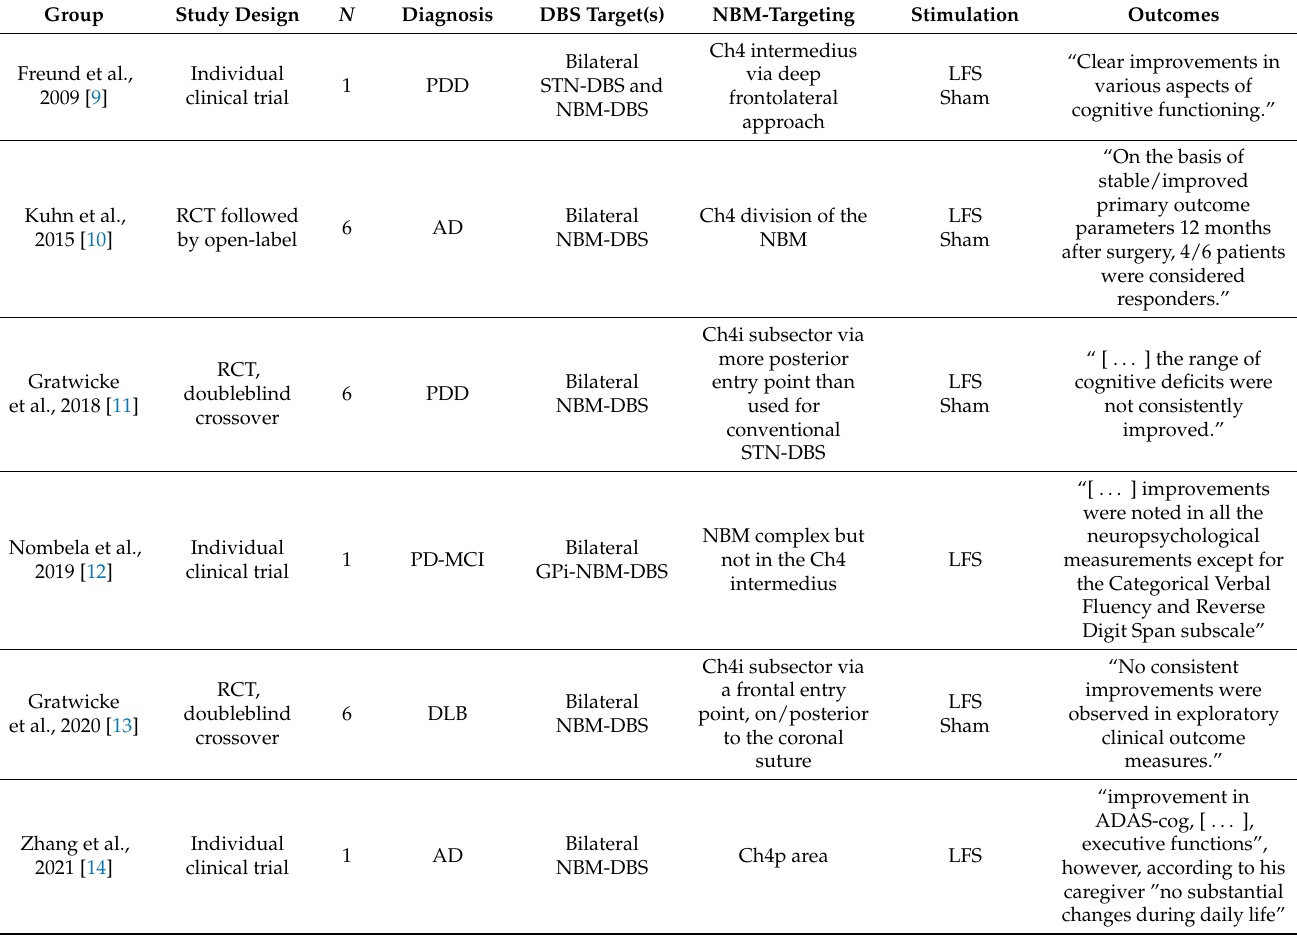
Table 1. Outcomes of